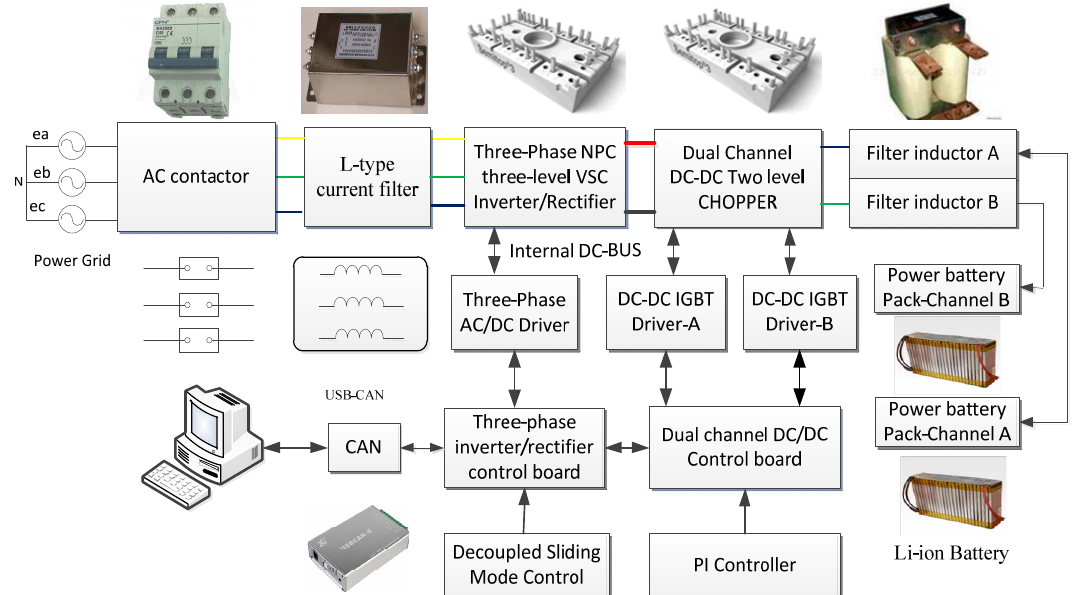
Figure 1. Block diagram of the ERLPABTS using an improved NPC-VSC